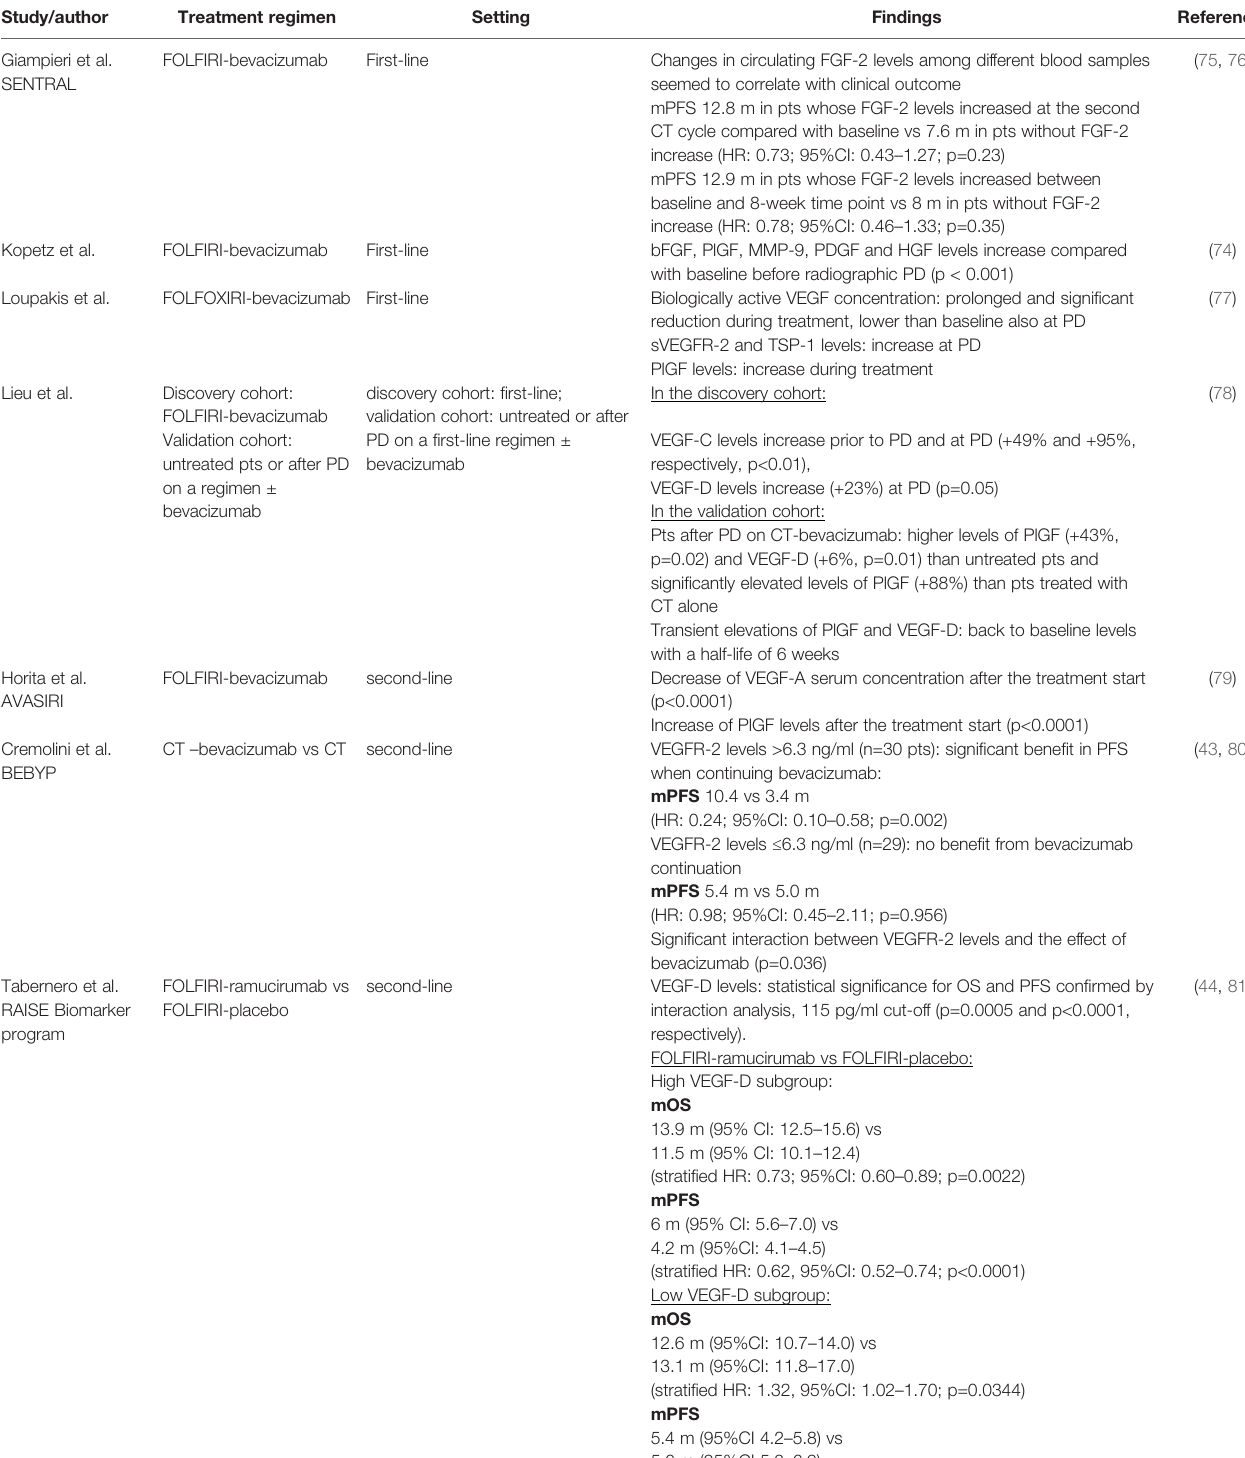
TABLE 3 | Circulating pro-angiogenic biomarkers